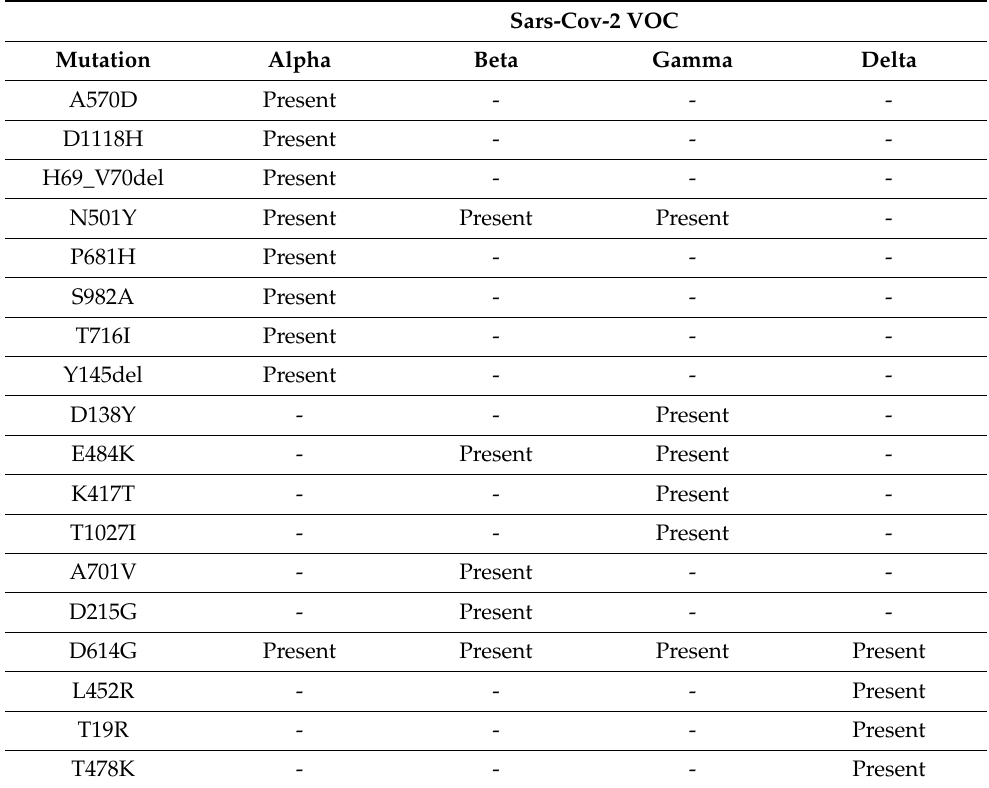
Table 2. Analysed mutations of spike protein present in Alpha, Beta, Gamma, and Delta SARS-CoV-2